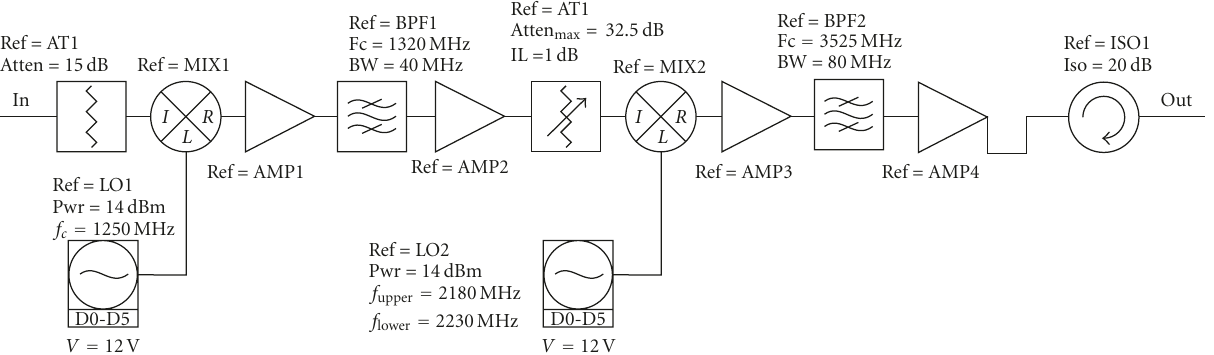
Figure 2: Radio Frequency TX Chain Modules